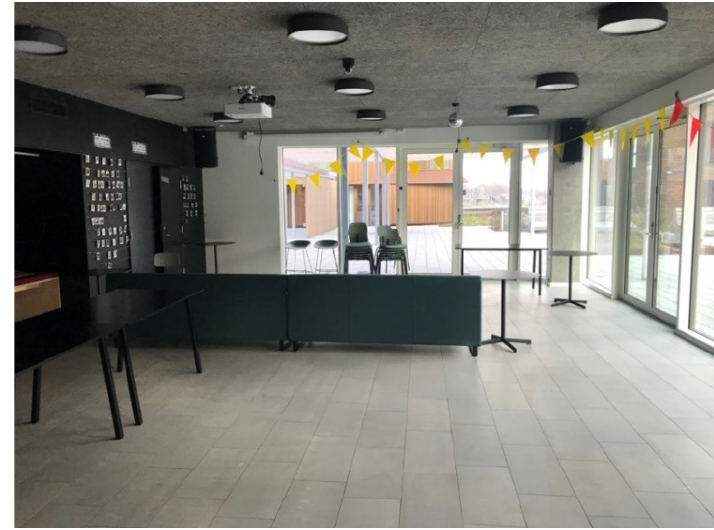
Figure 5. Bar for residential activities at Nordbro. While students and young people find these facilities fantastic, others feel excluded. This points to the importance of target groups and cohesion between lifestyle and shared facilities. Source: Mechlenborg and Hauxner (2021, p.